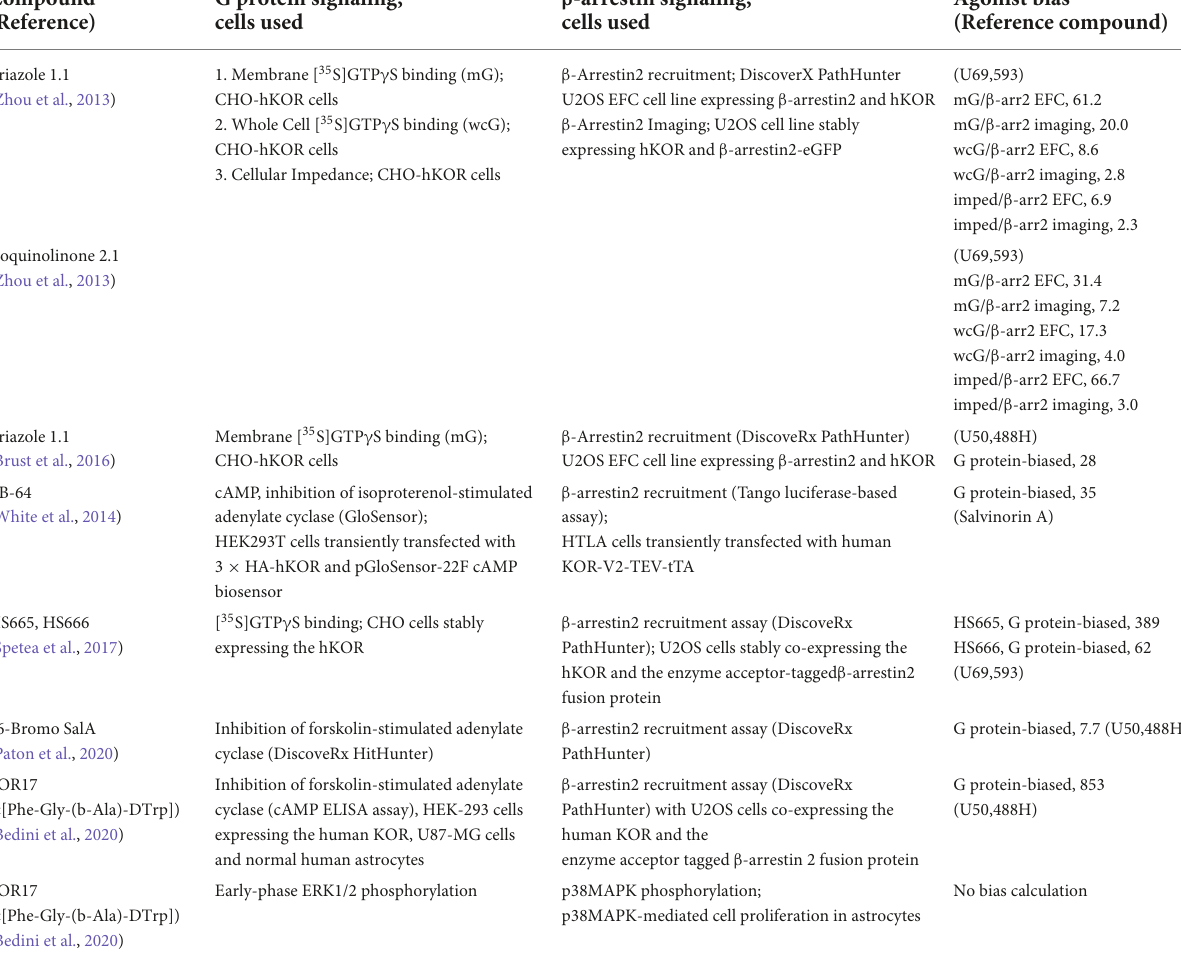
TABLE 3 In vitro agonist biases of novel G protein-biased KOR agonists which were investigated in vivo for analgesic or anti-scratch effects. Compound